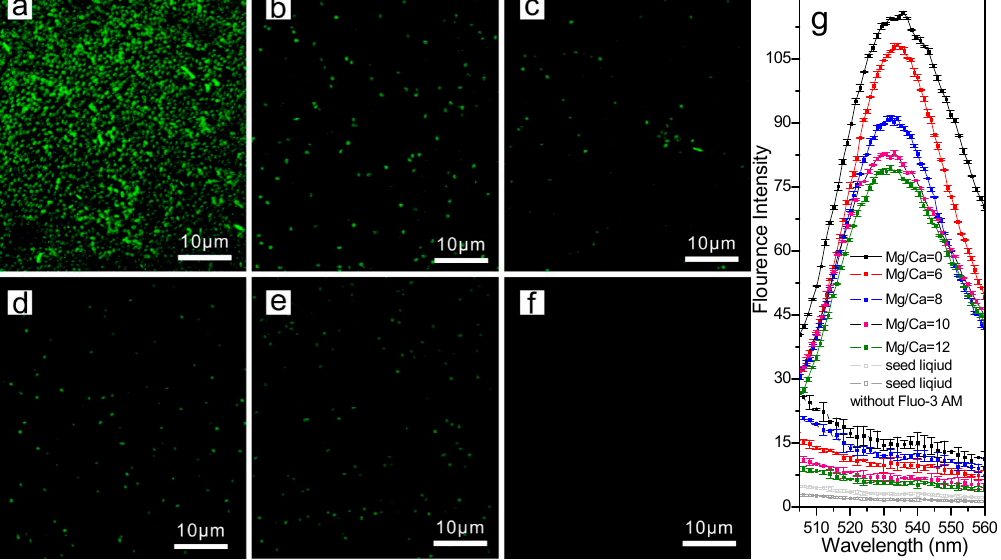
Figure 7. Analyses of intracellular Ca 2+ fluorescence intensity. ( a – e ) SRB2 bacteria stained with Fluo ‐ 3AM and analyzed by laser scanning microscopy at Mg/Ca molar ratios of 0, 6, 8, 10, and 12, respectively; ( f ) SRB2 bacteria without staining with Fluo ‐ 3AM analyzed by laser scanning microscopy; ( g ) Intracellular Ca 2+ fluorescence intensity of SRB2 bacteria analyzed by a fluorescence